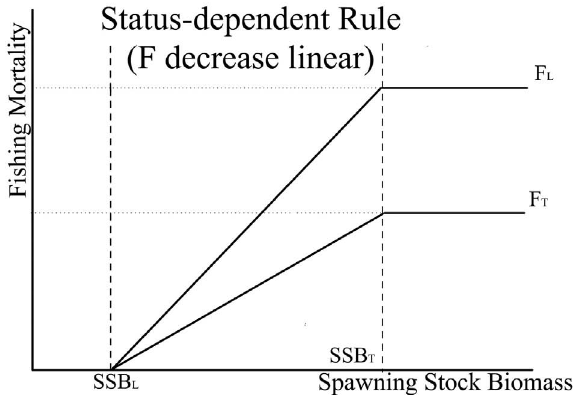
Fig . 3. – Graphic representations of management strategies con- sidered in this study ( F , target fishing mortality; F T mortality; SSB , target spawning stock biomass level, SSB T spawning stock biomass